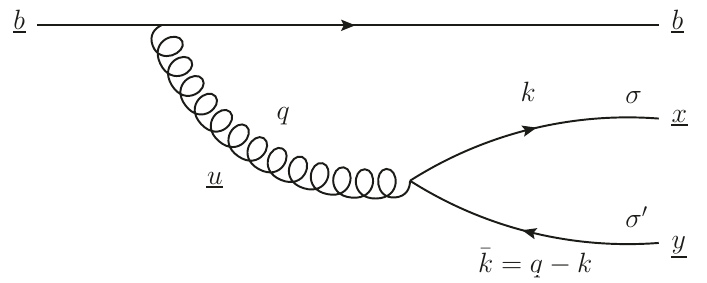
Figure 1 . The light-front wave functions to radiate a soft q (cid:22) q pair at mid-rapidity from a valence source, shown here as a